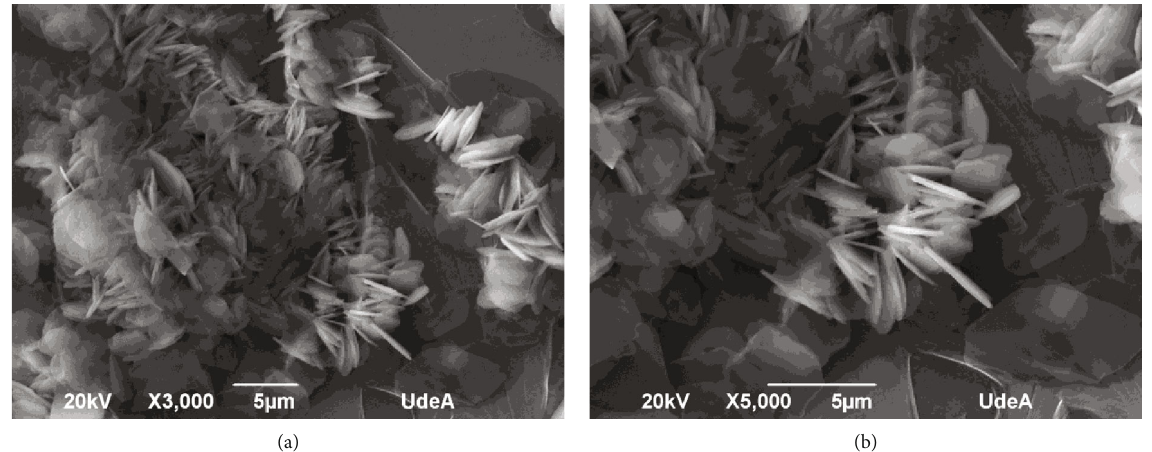
Figure 1: Scanning electron microscopy (SEM) images of the as-synthesized Cs-Al NDs at (a) × 3,000 and (b) × 5,000 magni fi